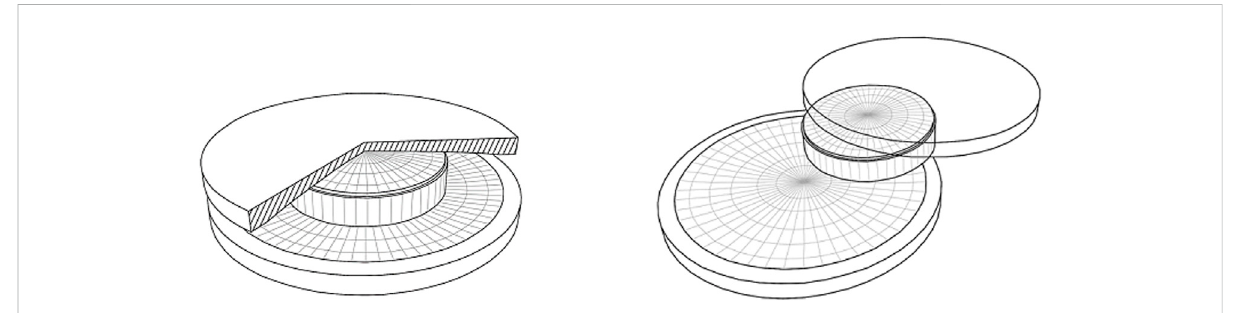
FIGURE 2 Perspective view of the DCCSS in the static condition and in the over-stroke